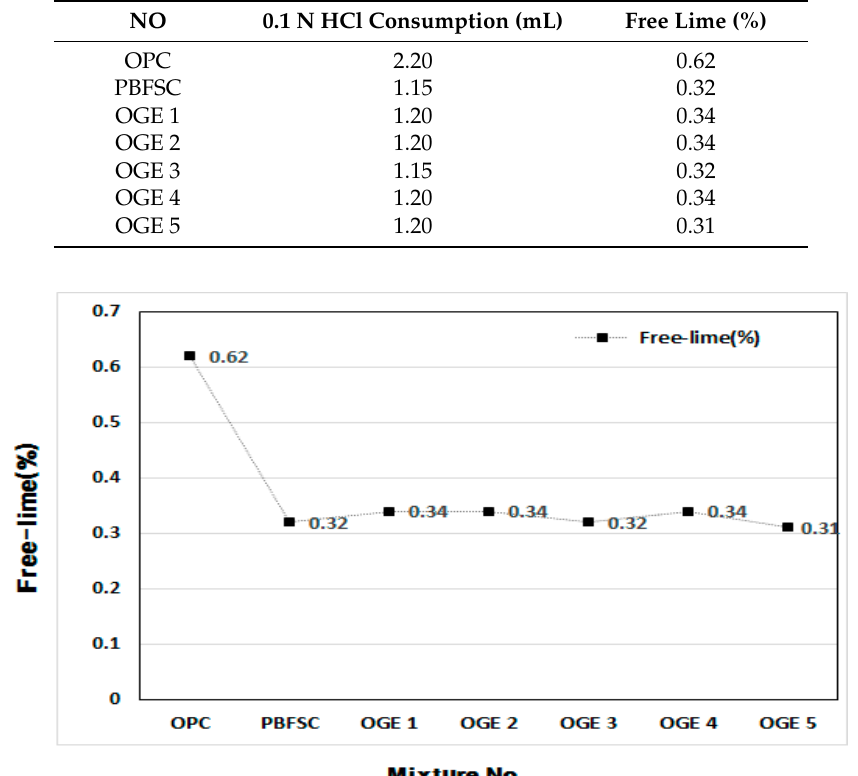
Table 8. Measurement of free-lime in OGE at different ESA burning temperatures.